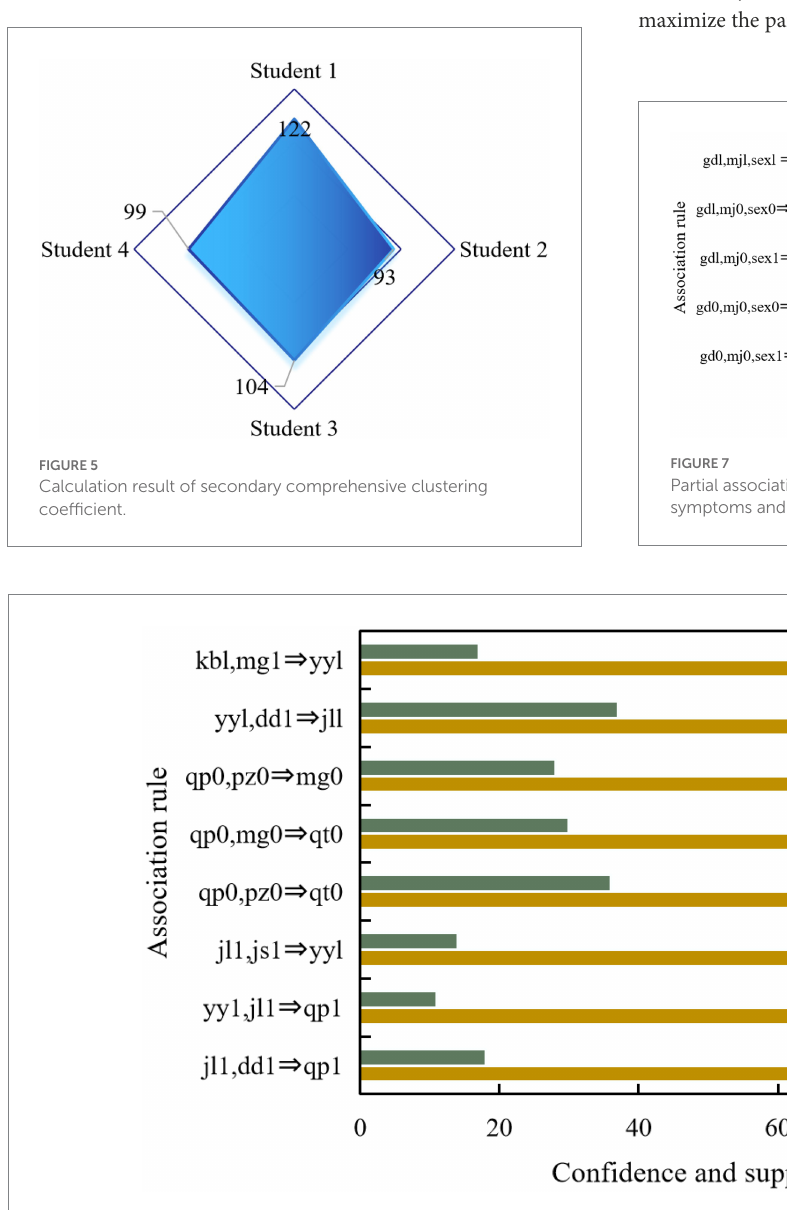
FIGURE 6 Partial association rules between psychological factors.